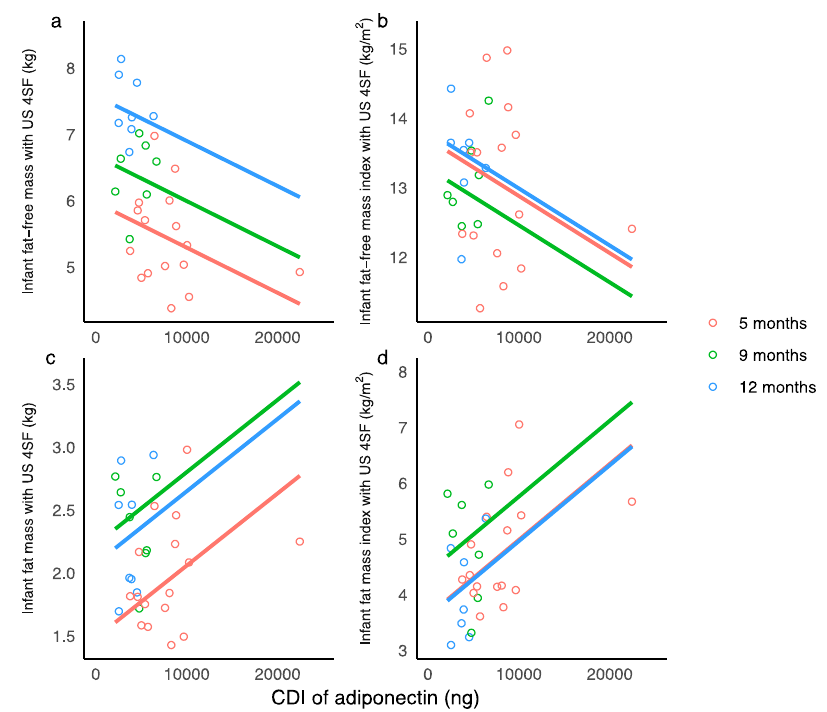
Figure 2. Significant associations between calculated daily intakes (CDI) of whole milk adiponectin. ( a ) Infant fat-free-mass measured with ultrasound 4-skinfolds (US 4SF); ( b ) infant fat-free mass index with US 4SF; ( c ) infant fat mass with US 4SF; ( d ) infant fat mass index with US 4SF. Lines represent linear regression and grouped by the month of lactation.